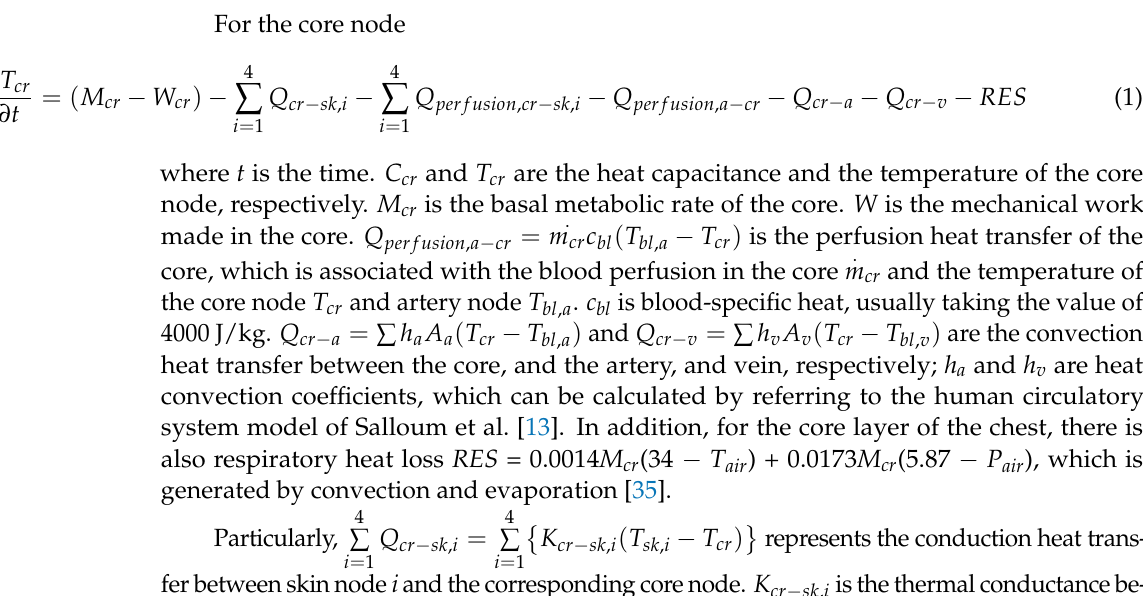
Table 2. Distribution coefficients of each body segment [11].